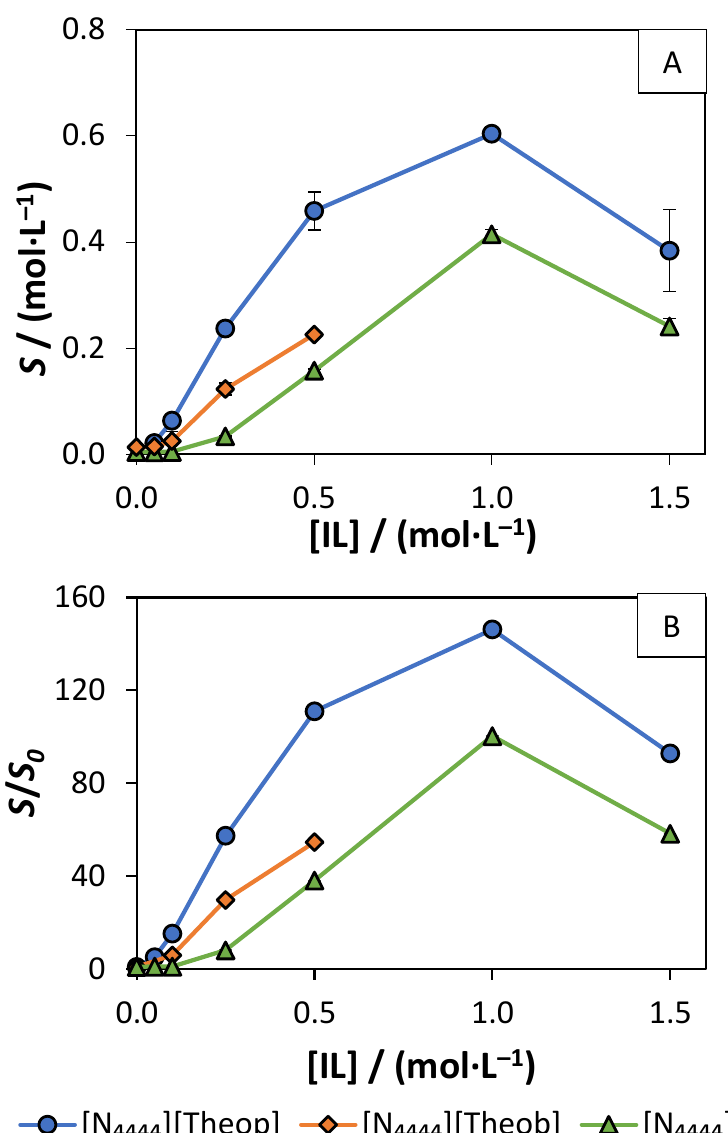
Figure 6. ( A ) Molar solubility of ferulic acid in IL solutions with different concentrations. ( B ) Molar aqueous solubility enhancement ( S / S 0 ) of ferulic acid in IL solutions with different concentrations. In both ( A ) and ( B ), different ILs are represented in different colors: [N 4444 ][Theop] (blue o), [N 4444 ][Theob] (orange ♦ ), and [N 4444 ]Cl (green ∆